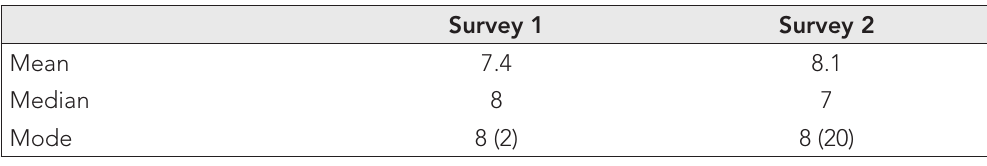
Table 2: How important is it to give global aid (scale of 1–10)?